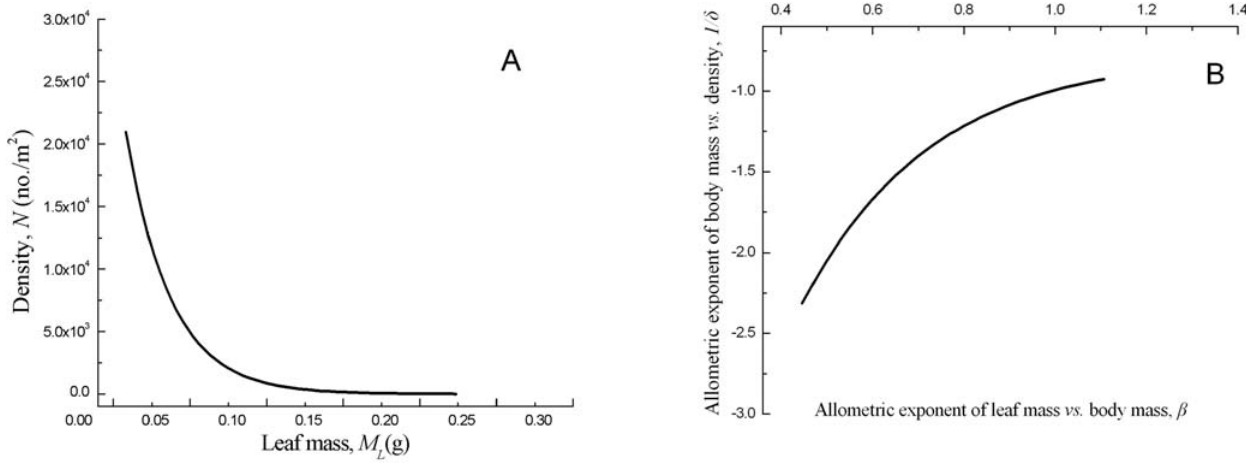
Figure 5. The trade-off relationships between population density vs . the photosynthetic mass/leaf mass (A) and the allometric exponents, 1/ d vs. b (B). The population density and the photosynthetic mass show a reciprocal relationship (A) and the exponents 1/ d and b show a negative reciprocal relationship (B).